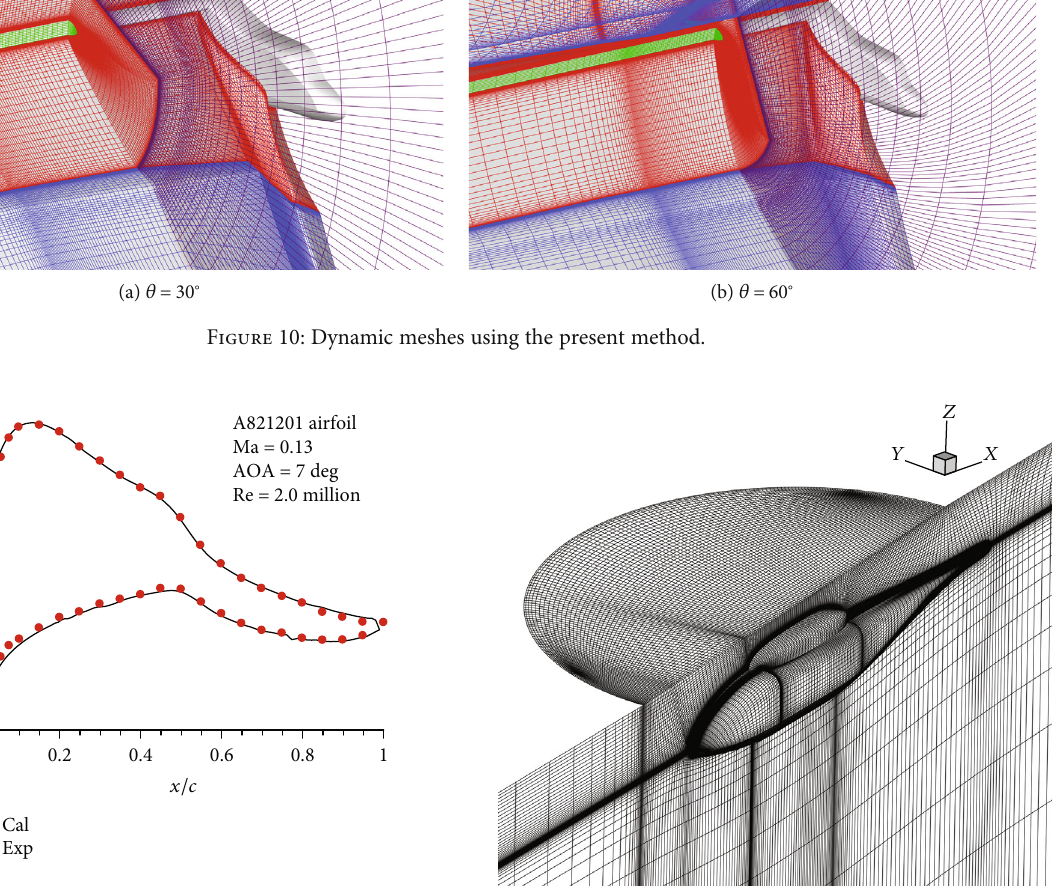
Figure 11: Surface pressure coe ffi cient distribution.